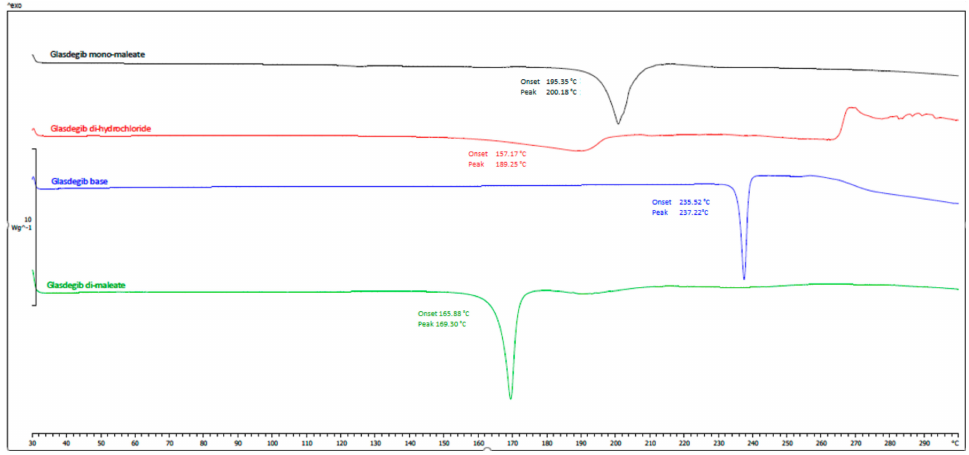
Figure 7. DSC thermograms of glasdegib derivatives. Black: glasdegib monomaleate, red: glasdegib dihydrochloride hydrate; blue: glasdegib base; and green: glasdegib